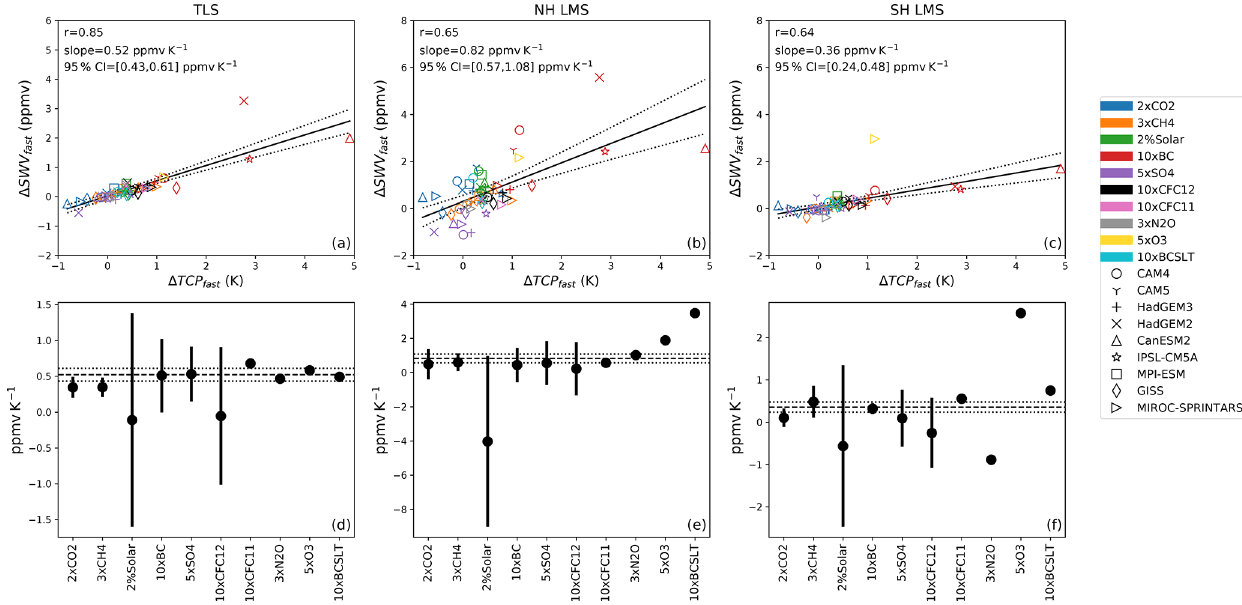
Figure 6. (a–c) Linear regression between (cid:49) SWV fast (ppmv) and (cid:49) TCP fast (K) from all models and perturbations. The color coding indicates different perturbations, while the marker shapes indicate results from different models. The black solid line is the linear fit of the regression. The black dotted lines indicate the linear fits within the 95% confidence interval, estimated using a t test. (d–f) Slopes and their 95% confidence intervals (for perturbations that are performed by more than three models) obtained from linear regression between (cid:49) SWV fast (ppmv) and (cid:49) TCP fast (K) for each individual perturbation. The black dashed lines and dotted lines are the slopes and their 95% confidence intervals of the regressions in (a) – (c)